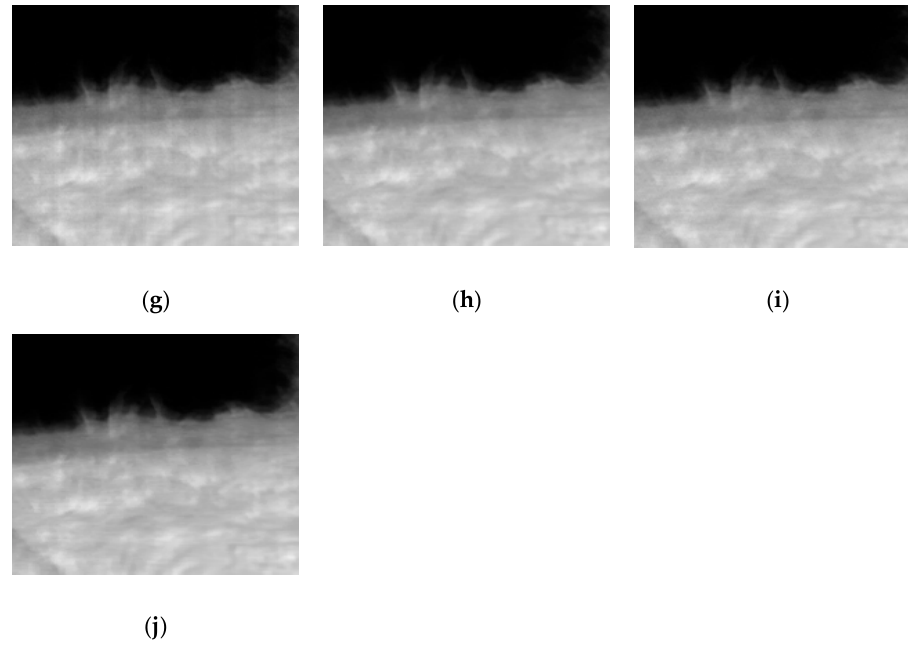
Figure 12. Various methods of stripe removal result on the solar sphere image. ( a ) Global image with noise; ( b ) the original image of the comparison area; ( c ) the noise image of the comparison area; ( d ) WAFT; ( e ) UTV; ( f ) VSNR; ( g ) ASSTV; ( h ) SILR; ( i ) ℓ (cid:2868) sparse; ( j ) LRSUTV.